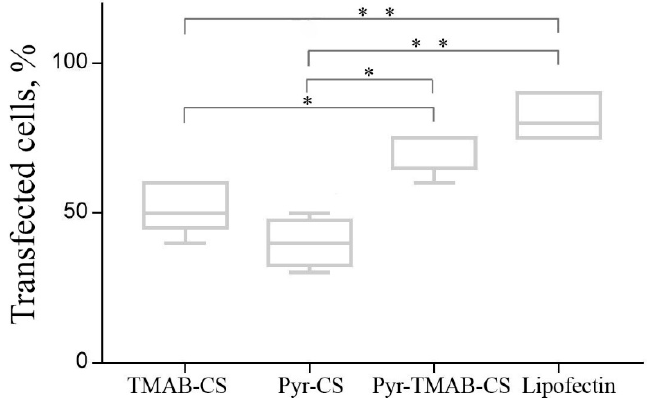
Figure 8. Transfection efficiency of polyplexes at different polymer:DNA mass ratios. Individual points represent mean ± SD, n = 8.